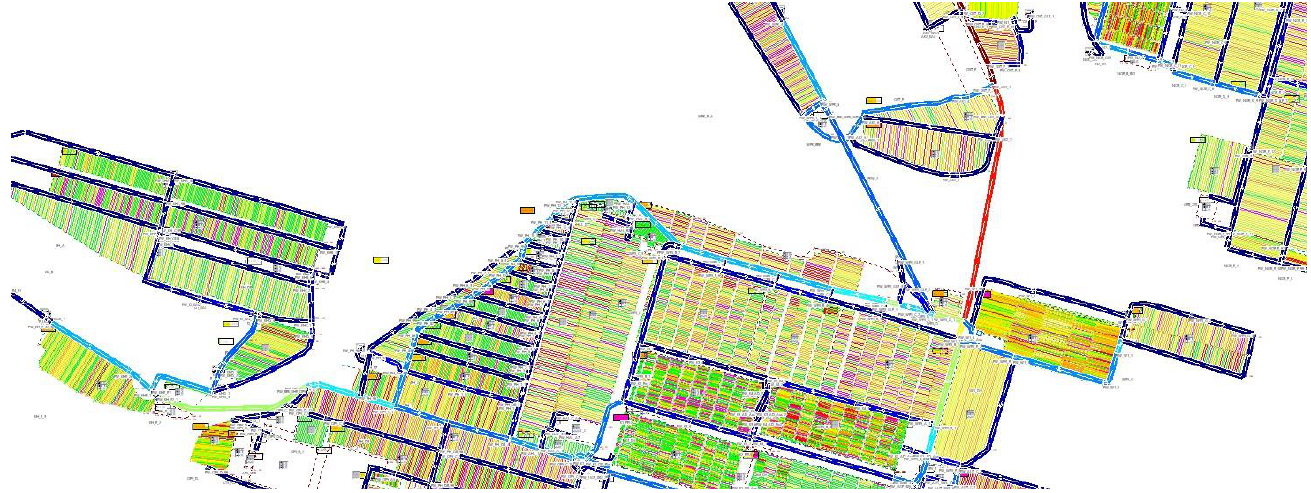
Figure 3. Terminal`s implementation in a simulation model. Figure 3. Terminal’s implementation in a simulation